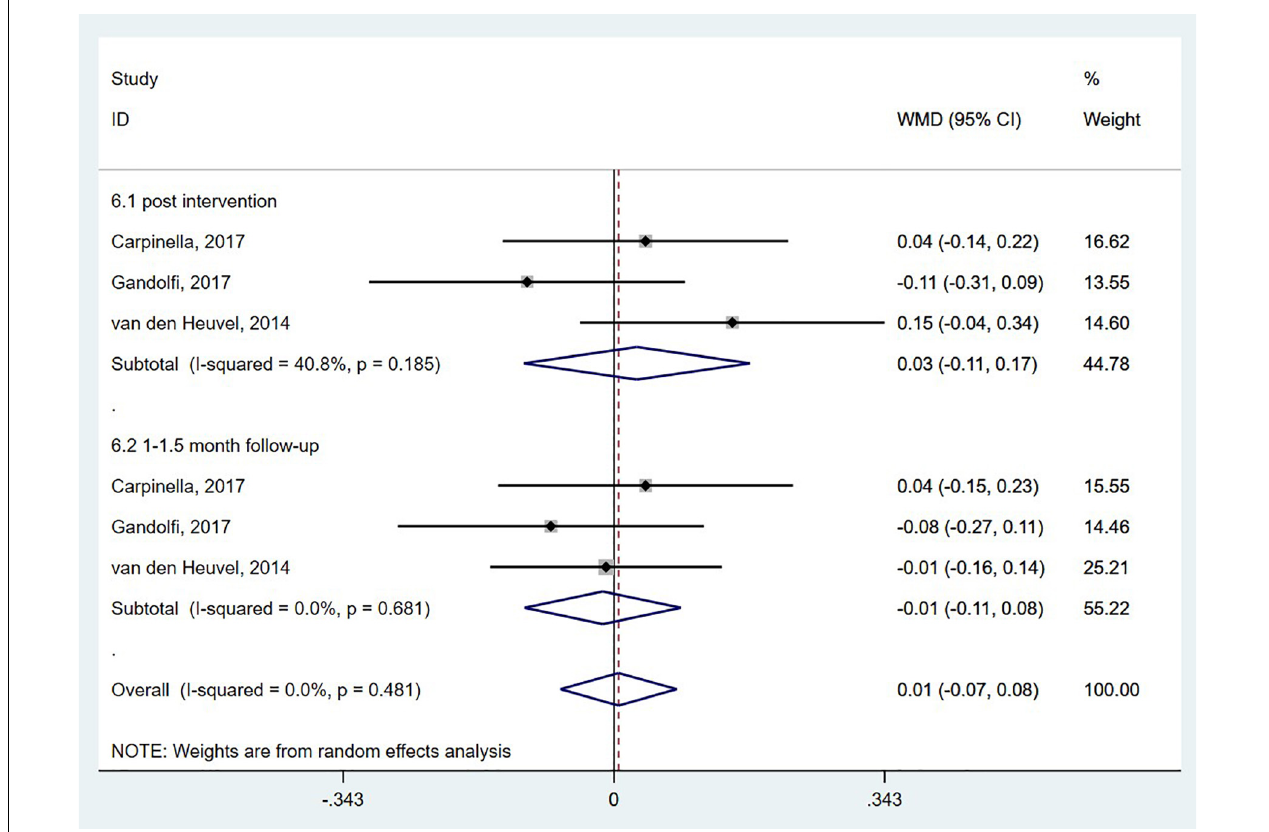
FIGURE 6 | Forest plot of pooled results for 10-meter walking